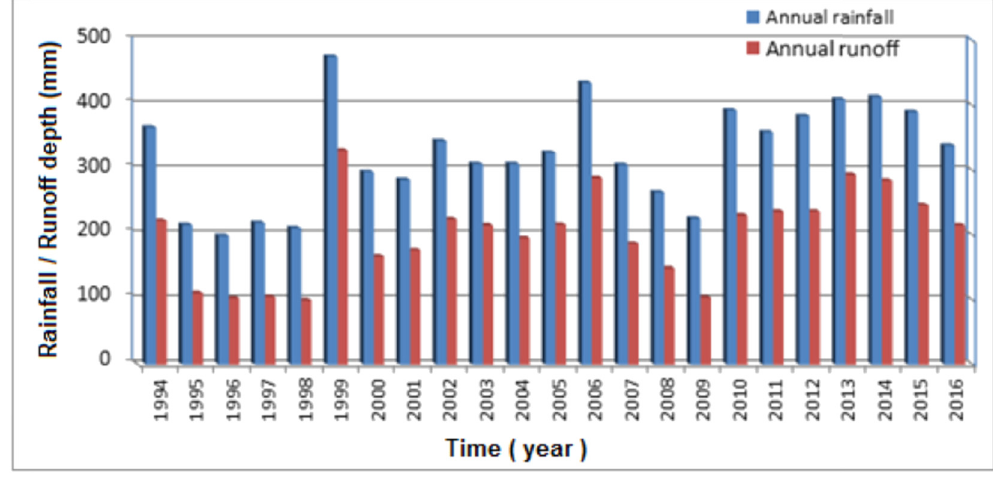
Figure 4: Annual runo ff of basin 1 [ 16 ] .